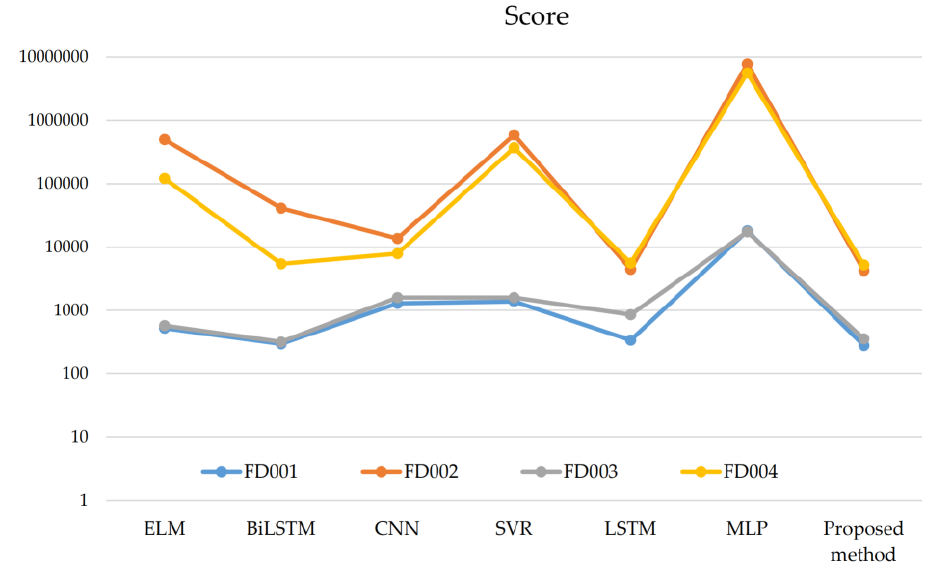
Figure 6. The results of Score comparison among different methods.